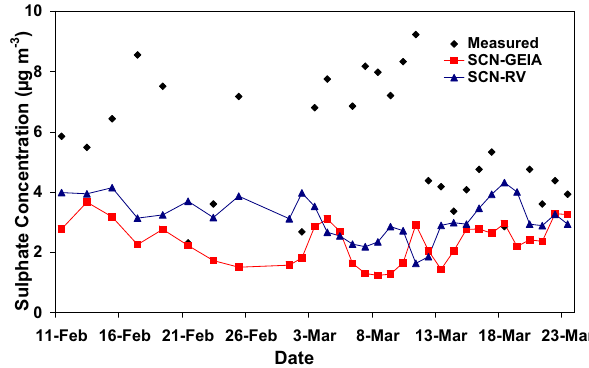
Fig. 3. Modelled (squares and triangles) and observed sulphate (di- amonds) concentration at Kaashidhoo [73.46 ◦ E, 4.96 ◦ N] during INDOEX-IFP.